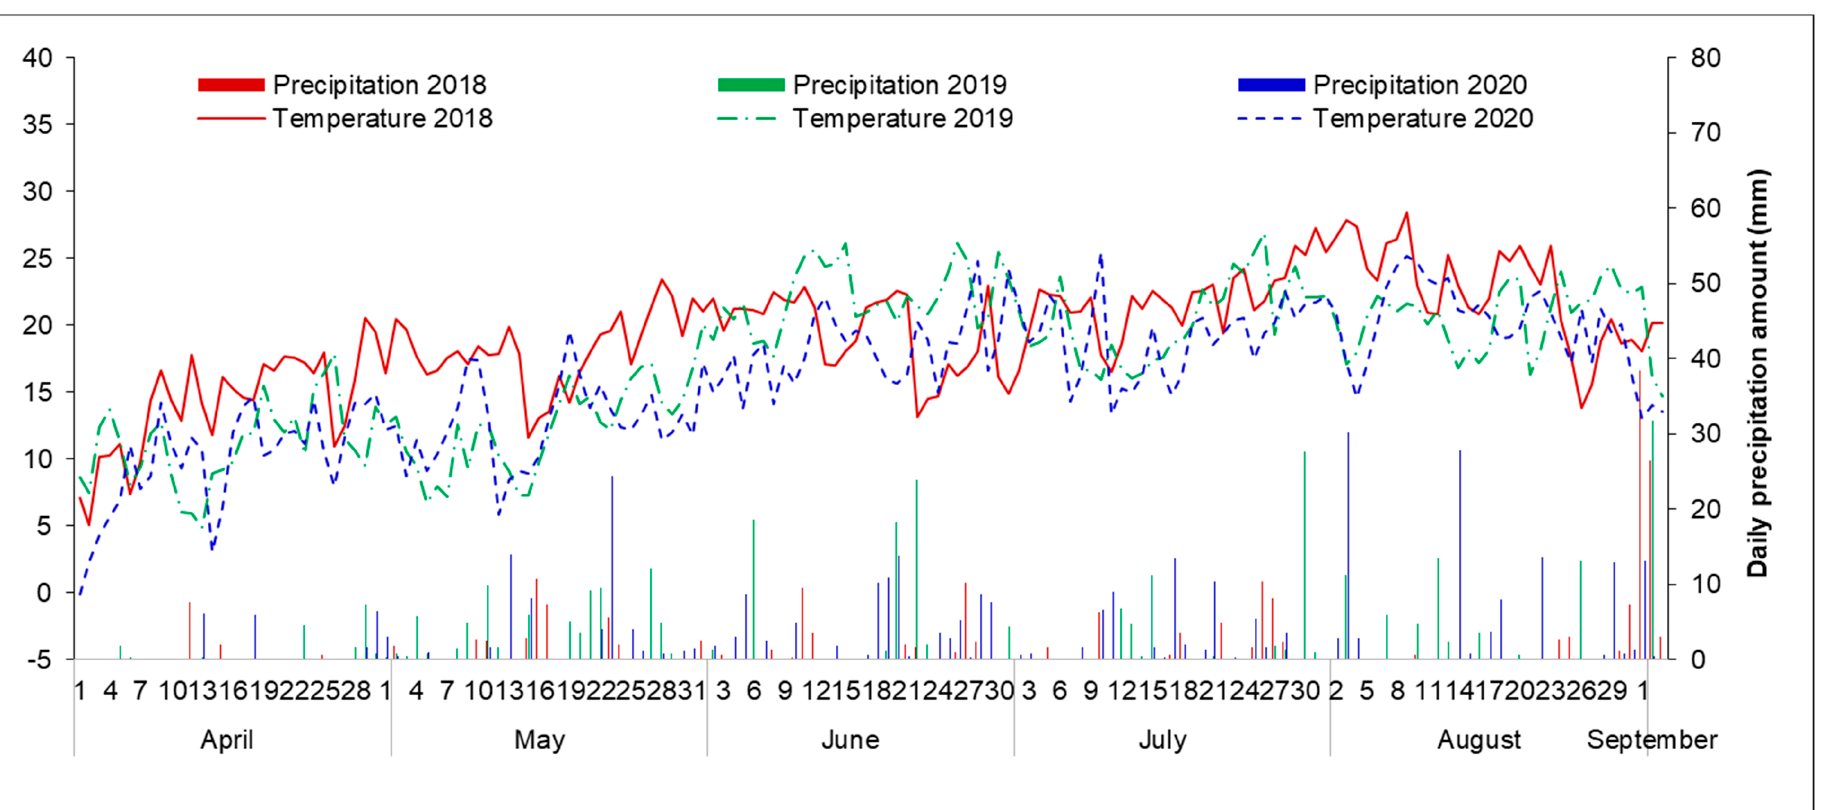
Figure A10. Average daily temperatures and daily precipitation amounts in the growing seasons of period 2018–2020. The values were measured by the professional meteorological station (ID: B2TROU01; type: AKS2) which is operated by the Czech Hydrometeorological Institute.